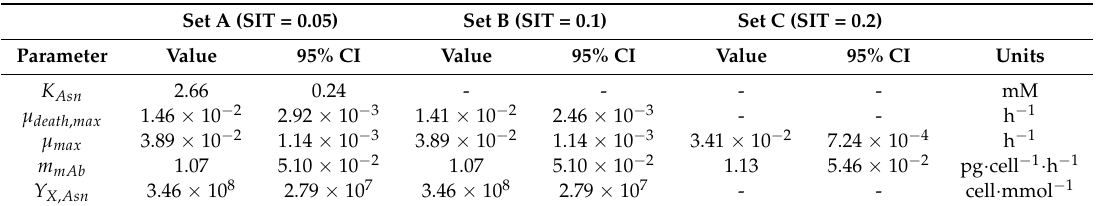
Table 3. Parameter estimation results for all parameter sets (A, B, C) including parameter values and their 95% confidence intervals. Set A (SIT = 0.05) Set B (SIT = 0.1) Set C (SIT =